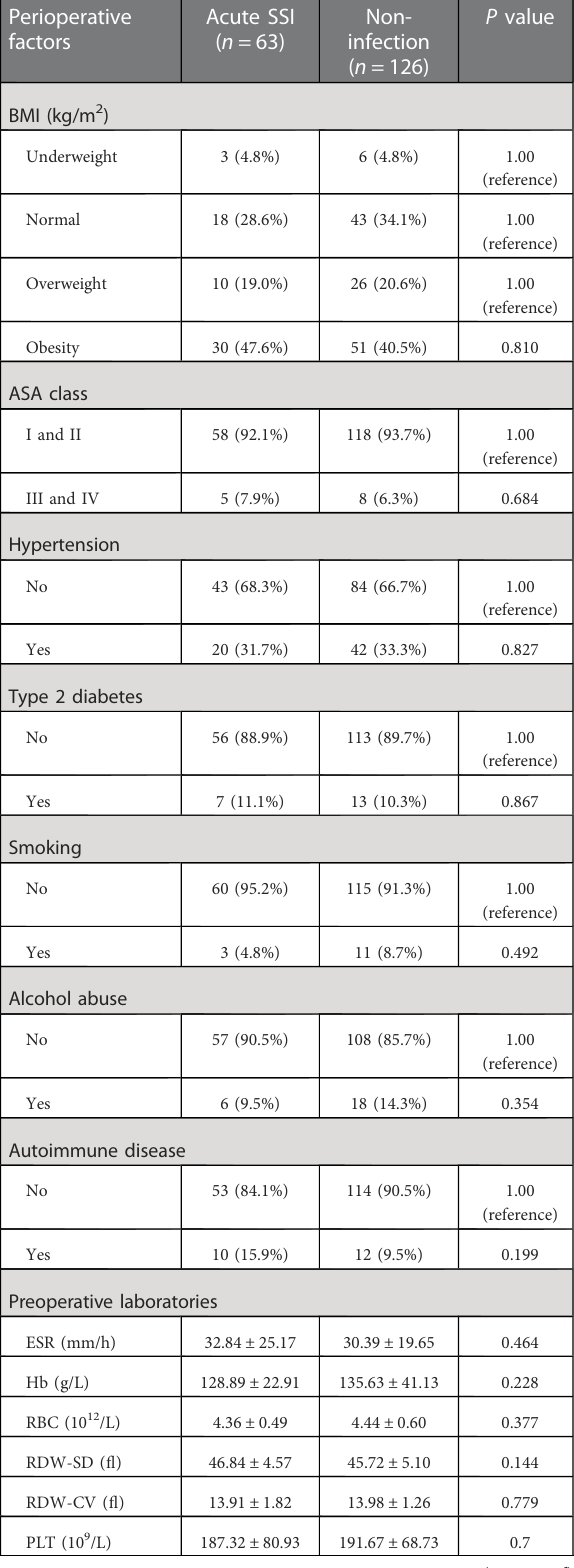
TABLE 5 Univariable analysis of risk factors for acute SSI after TJA. Perioperative factors